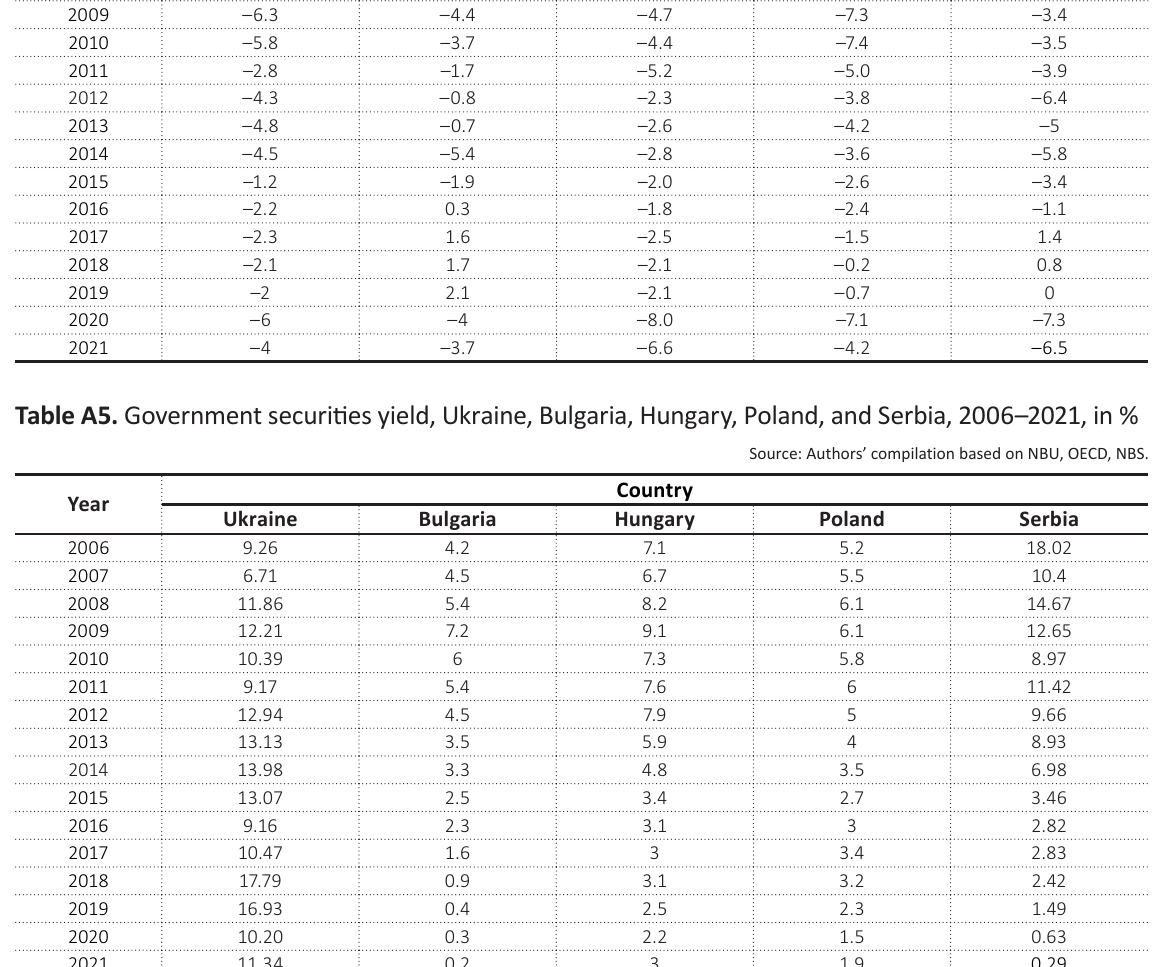
Table A4. Primary balance-to-GDP ratio, Ukraine, Bulgaria, Hungary, Poland, and Serbia, 2006–2021, in %